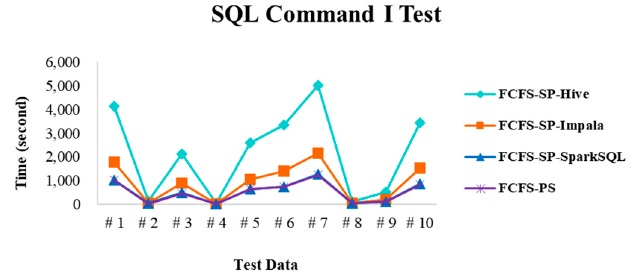
Figure 25. Execution time of SQL command I in test environment III.